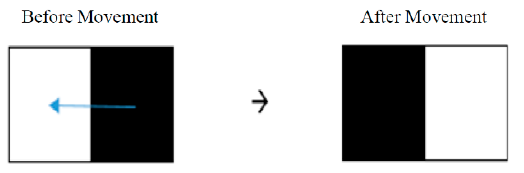
Figure 1. One movement in the puzzle using a white cell.